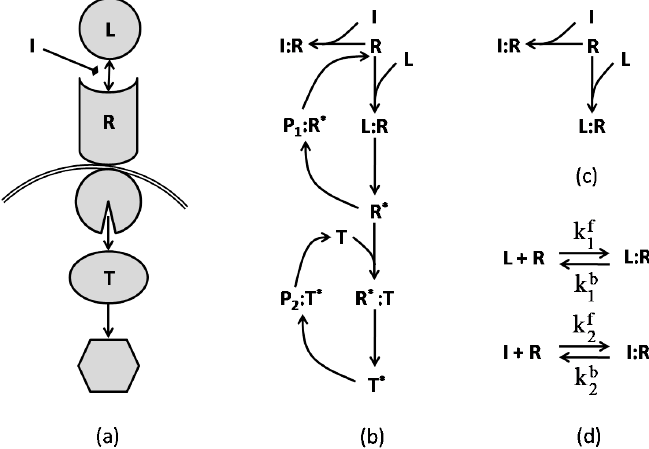
Figure 6. Single target pathway, where L is the ligand, R is the receptor, T is the target protein, I is the inhibitor, R ∗ , T ∗ are activated receptor and protein, and P 1 , P 2 are phosphotase: ( a ) Regulatory graph; ( b ) Reaction graph; ( c ) Basic reaction graph involving the ligand, inhibitor and receptor; ( d ) Chemical reaction network for the basic